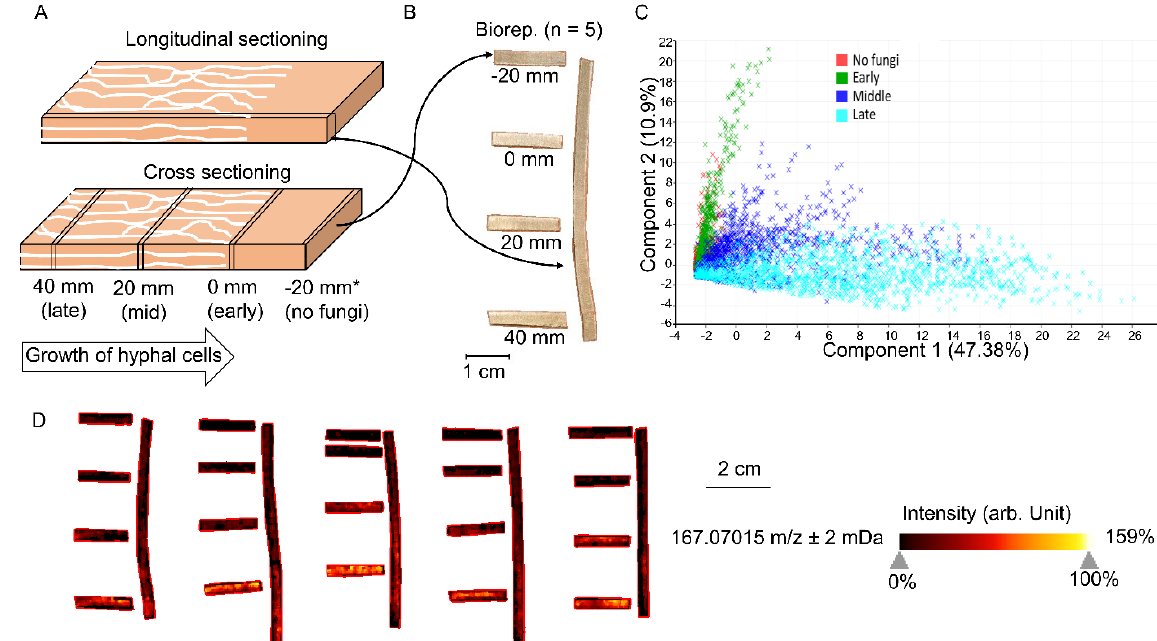
Figure 1. MALDI-FTICR-MS analysis of wood wafers decayed by Rhodonia placenta , showing the temporal changes of LMW metabolites. ( A ) The longitudinal section parallel with fungal growth direction and four cross-section slices at different distances from the hyphal front ( − 20, 0, 20, 40 mm) were sampled using a pair of blades to track the metabolites from early to late decay stages. ( B ) The generated slices with thickness of 0.5 mm were then mounted onto a target plate for MALDI-FTICR-MS analyses. ( C ) PCA plot of MS data over five bioreplicates was used to show the metabolite distributions across different stages of brown rot. Each dot represents one spectrum (pixel) from the analyzed slice. ( D ) MALDI-FTICR-MS images of one representative ion 167.07015 m/z ± 2 mDa are shown as an example, to delineate the temporal changes of metabolites along with brown rot. The specific intensities of this ion in five replicates were shown in Table S1.